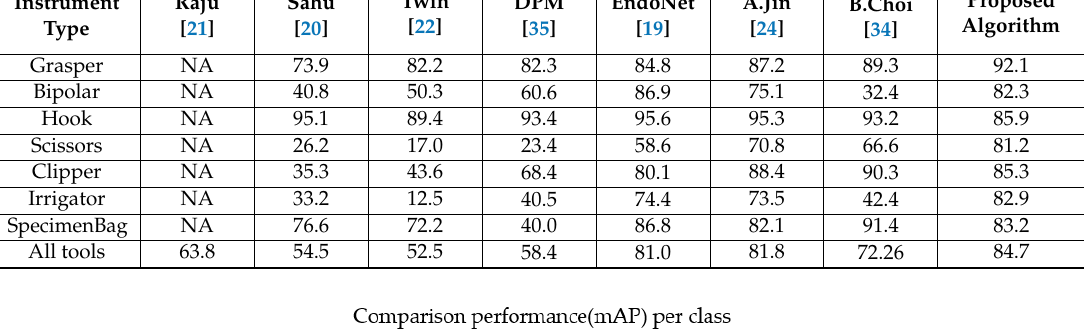
Table 2. Comparison performance using mAP.